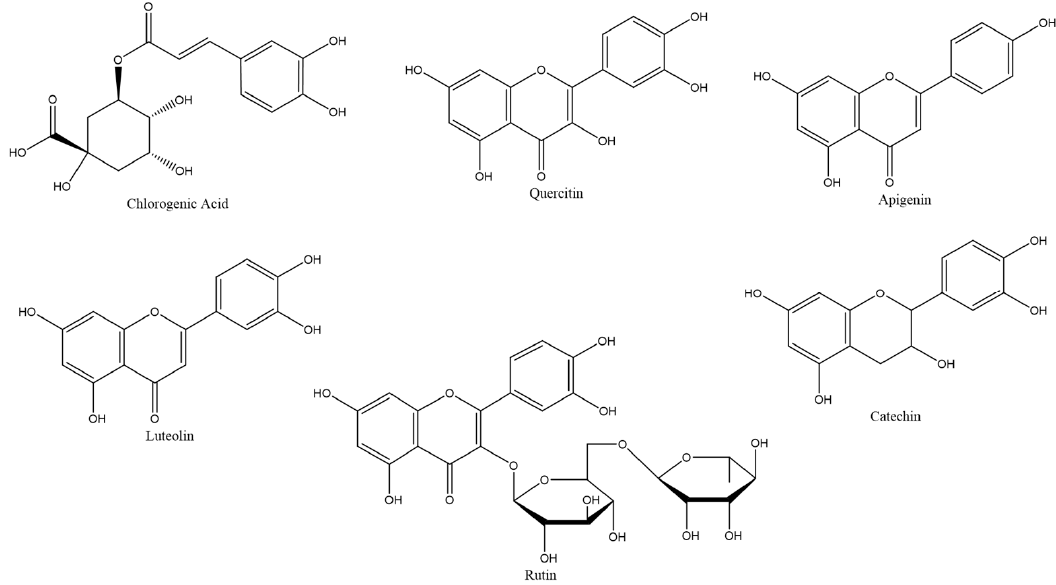
Figure 3. Chemical structures of commonly found phenolic